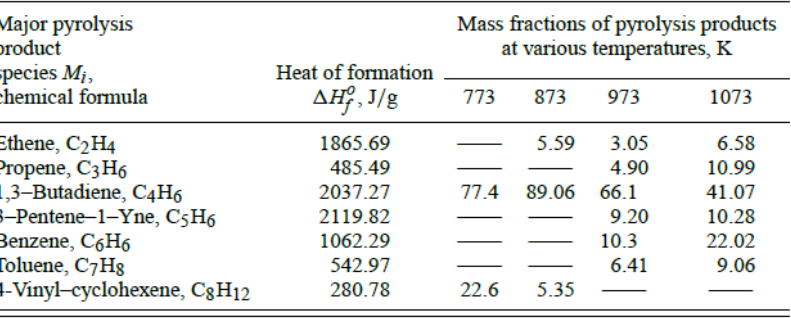
Figure 19. Image and table from Chiaverini [60], showing the composition and mean molecular mass of HTPB decomposition products at different